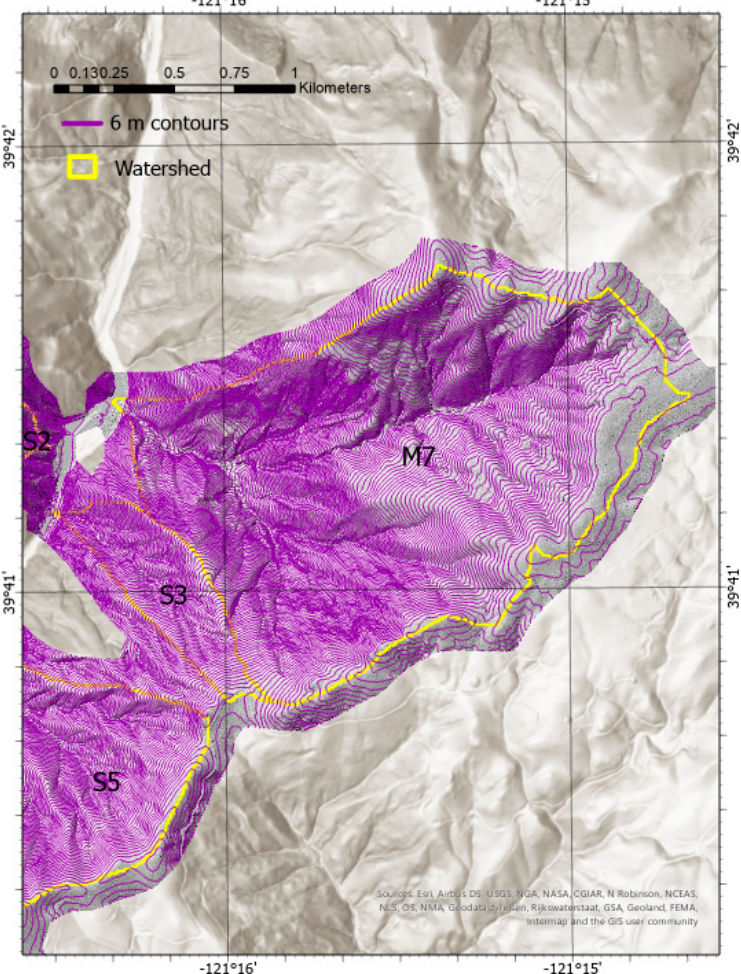
Figure 2. A 6 m contour map of watershed M7 showing the steeper topography in the lower portion of the watershed when compared with the upper portion of the watershed.